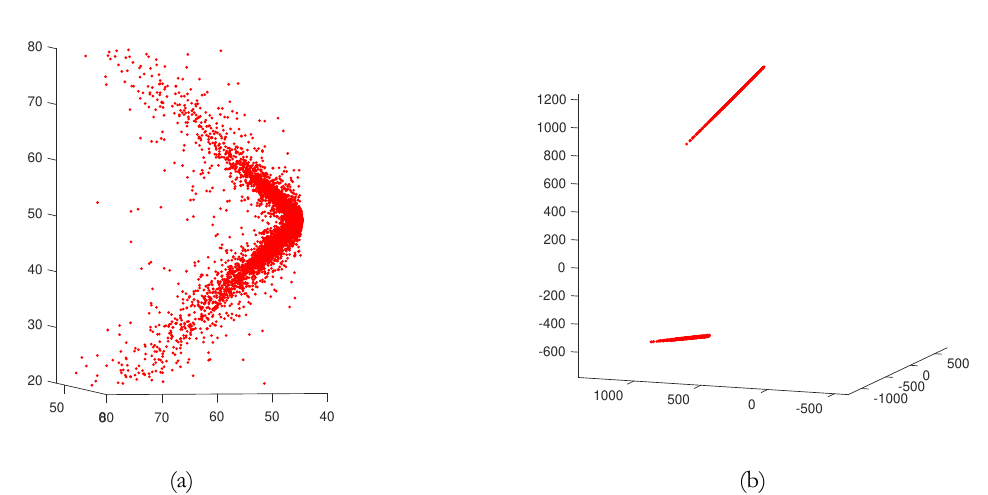
Fig. 1:One-spoke radial data set and outliers